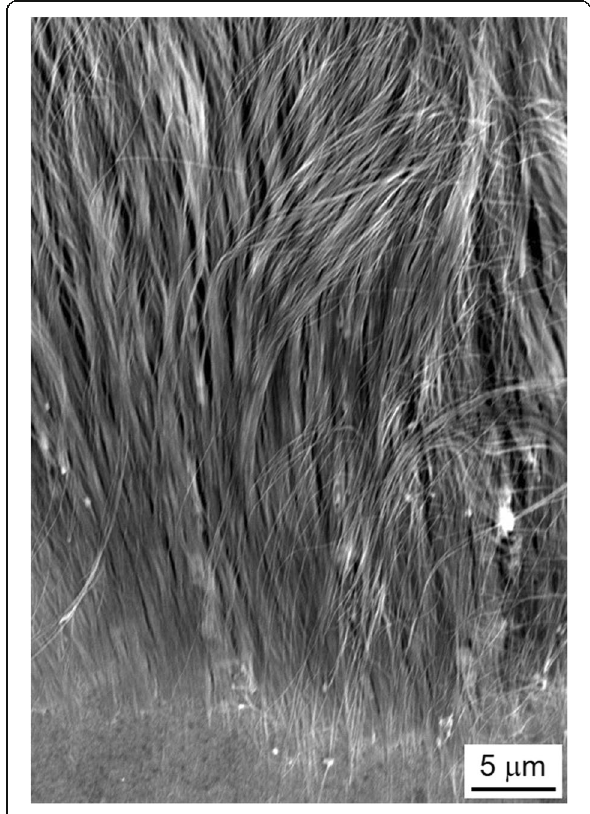
Fig. 5 SEM cross-section image of arrayed Fe nanowires separated from a AAO